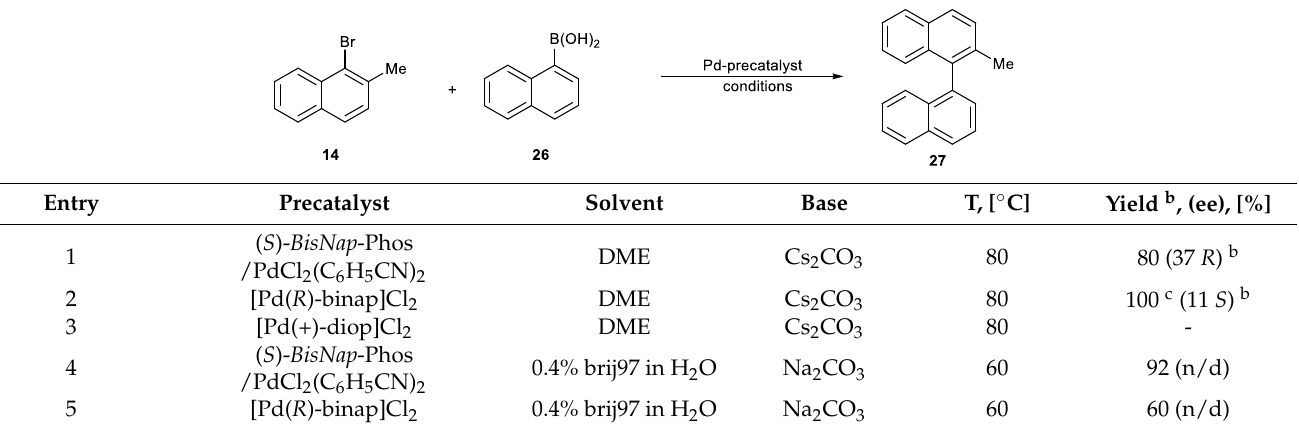
Table 12. Ligand activity in asymmetric synthesis of 2-methyl-1,1′ -binaphthyl ( 27 ) a .